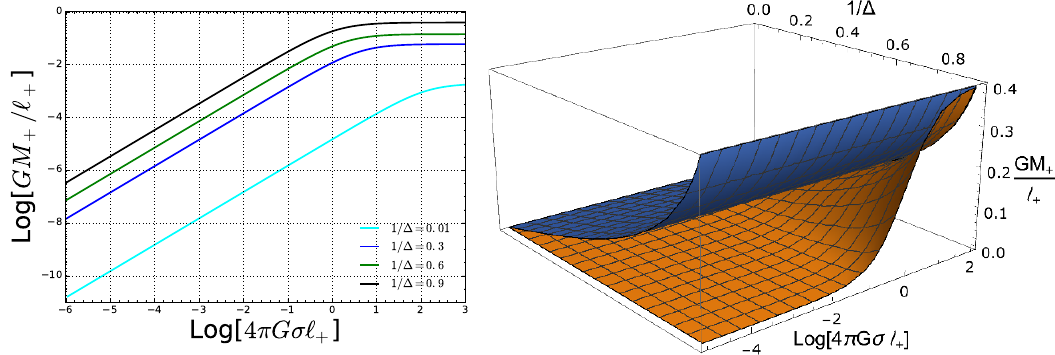
Figure 2 . Left: the special case M − = 0. It yields a relation between σ and M + in units of ℓ + for a particular value of ∆. Right: maximum and minimum mass for which the transition is possible in blue and orange respectively. The region in between these two surfaces is the allowed parameter region. Note that they never cross, as it should